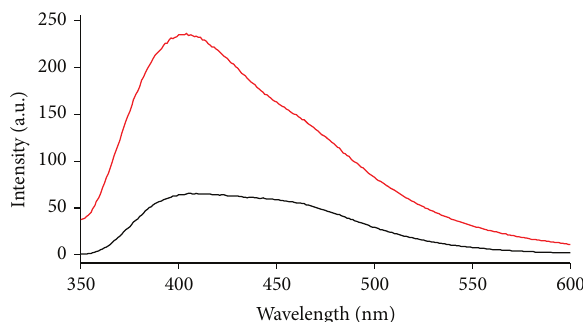
Figure 6: Emission of resveratrol (red line) and resveratrol in presence of S7-OD (black